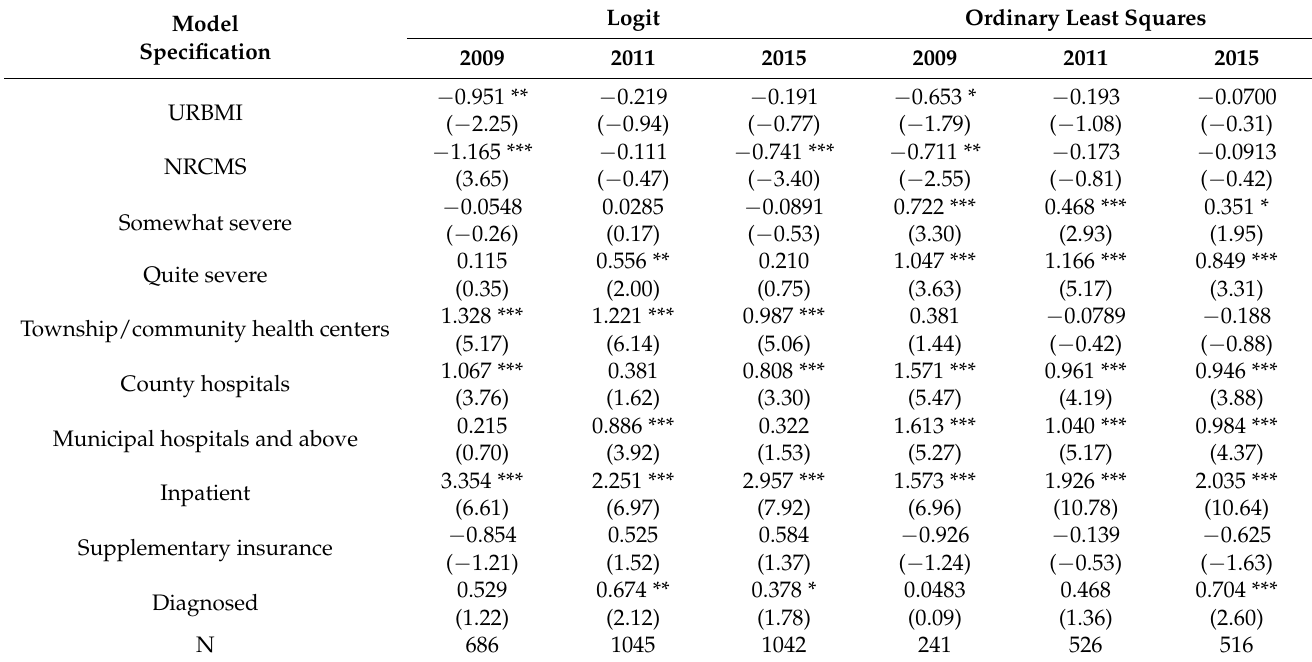
Table 6. Regression results of factors associated with reimbursement rate and reimbursement amount in each survey wave using the two-part